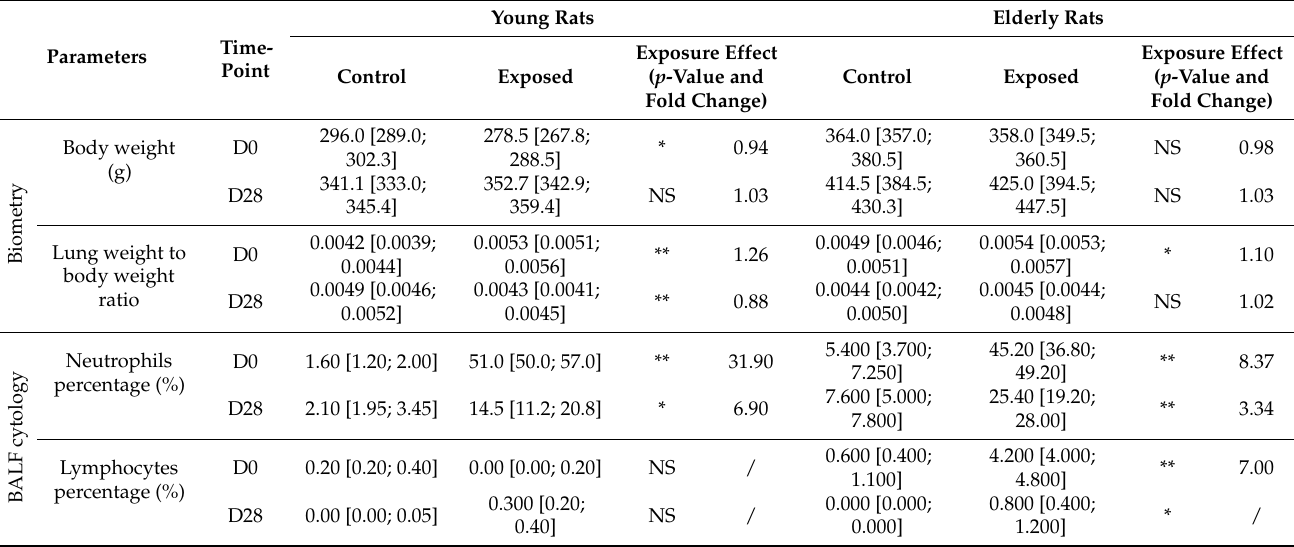
Table 2. Physiological